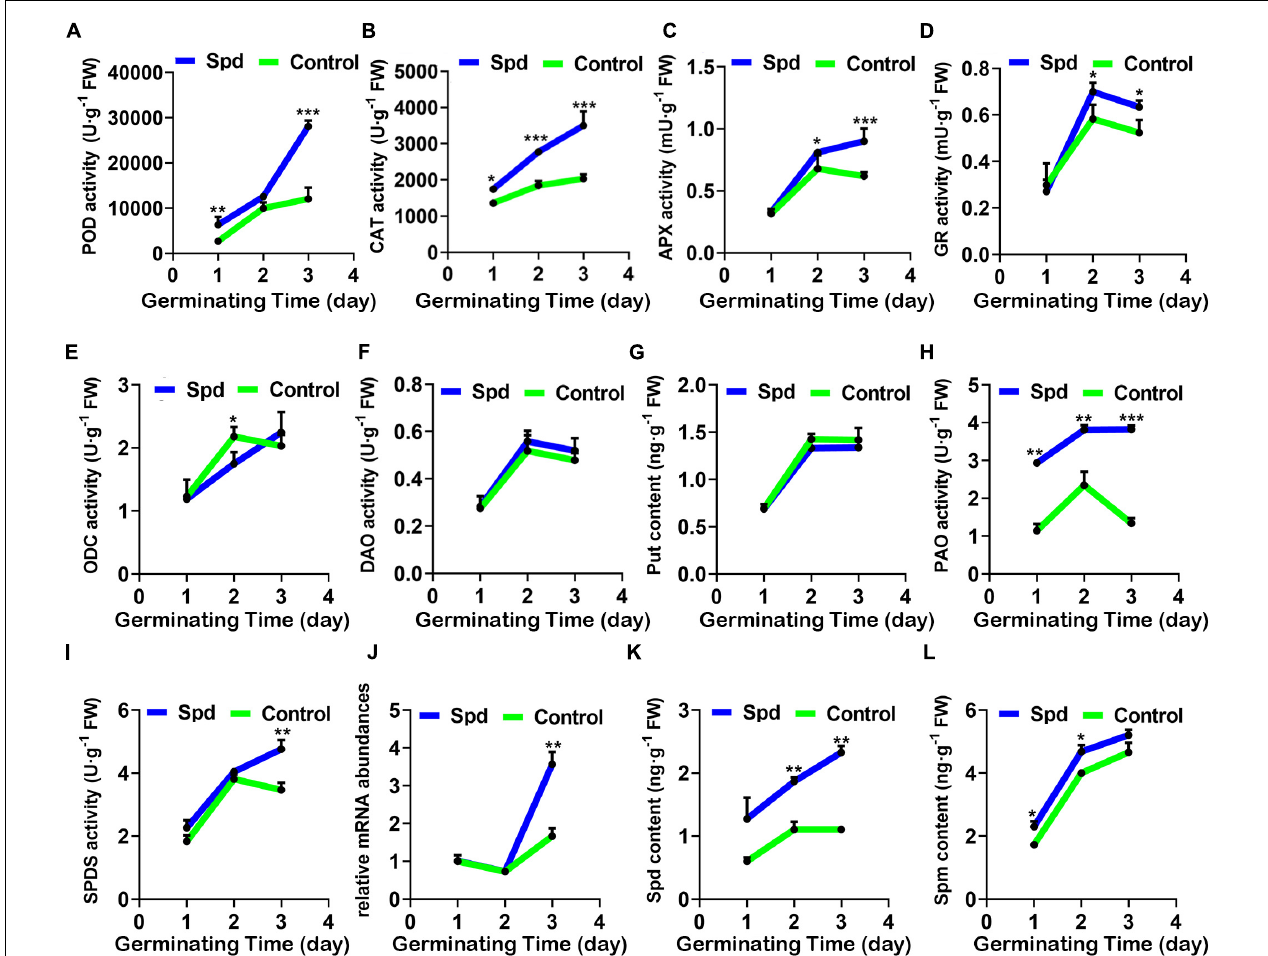
FIGURE 5 | Activity changes of enzymes involved in the regulation of H 2 O 2 and polyamines of Spd priming mediated. (A) POD activity. (B) CAT activity. (C) APX activity. (D) GR activity. (E) ODC activity. (F) DAO activity. (G) Content of Put. (H) PAO activity. (I) SPDS activity. (J) Relative expression of SPDS mRNA. (K) Content of Spd. (L) Content of Spm. The others are the same as in Figure 1 . Put, putrescine; Spd, spermidine; Spm, spermine; CAT, catalase; POD, peroxidase; GR, glutathione reductase; APX, ascorbate peroxidase; ODC, ornithine decarboxylase; DAO, diamine oxidase; PAO, polyamine oxidase; SPDS, spermidine synthase. Vertical bars indicate mean ± SD ( n = 3), and * or ** or *** indicates a significant difference at the level of p < 0.05 or at the level of p < 0.01 or at the level of p < 0.001,